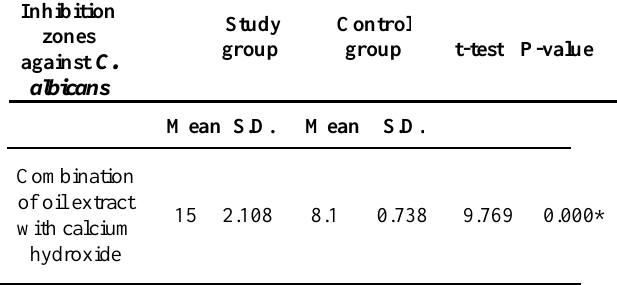
Table 3: Comparison between the antifungal activity of the study and control groups against Candida albicans . Inhibition Study Control zones group group t-test P-value against C. albicans Mean S.D. Mean S.D. Combination of oil extract 15 2.108 8.1 0.738 9.769 with calcium hydroxide [*] Highly significant